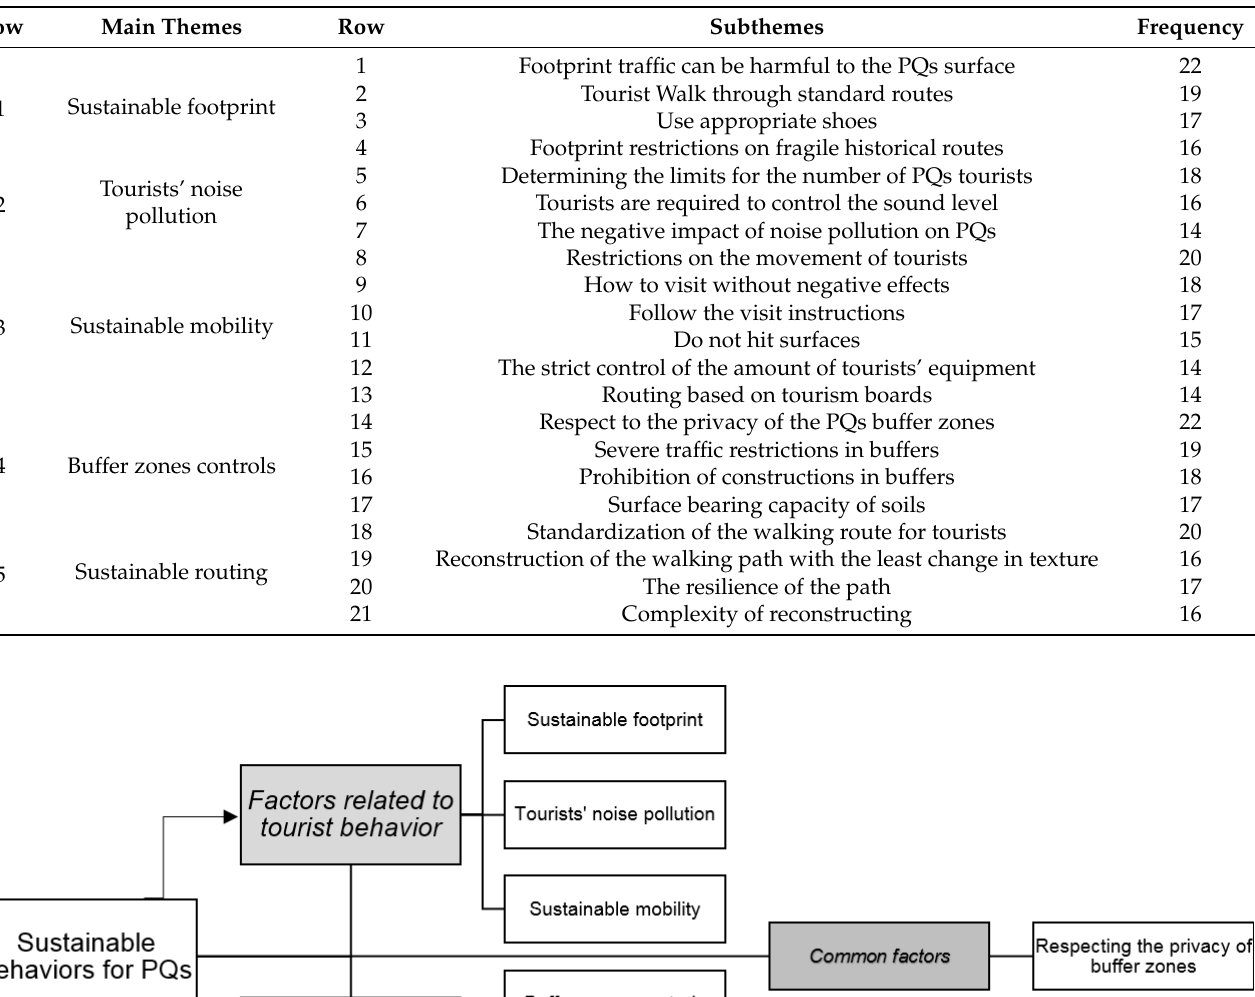
Table 2. Theme analysis results.